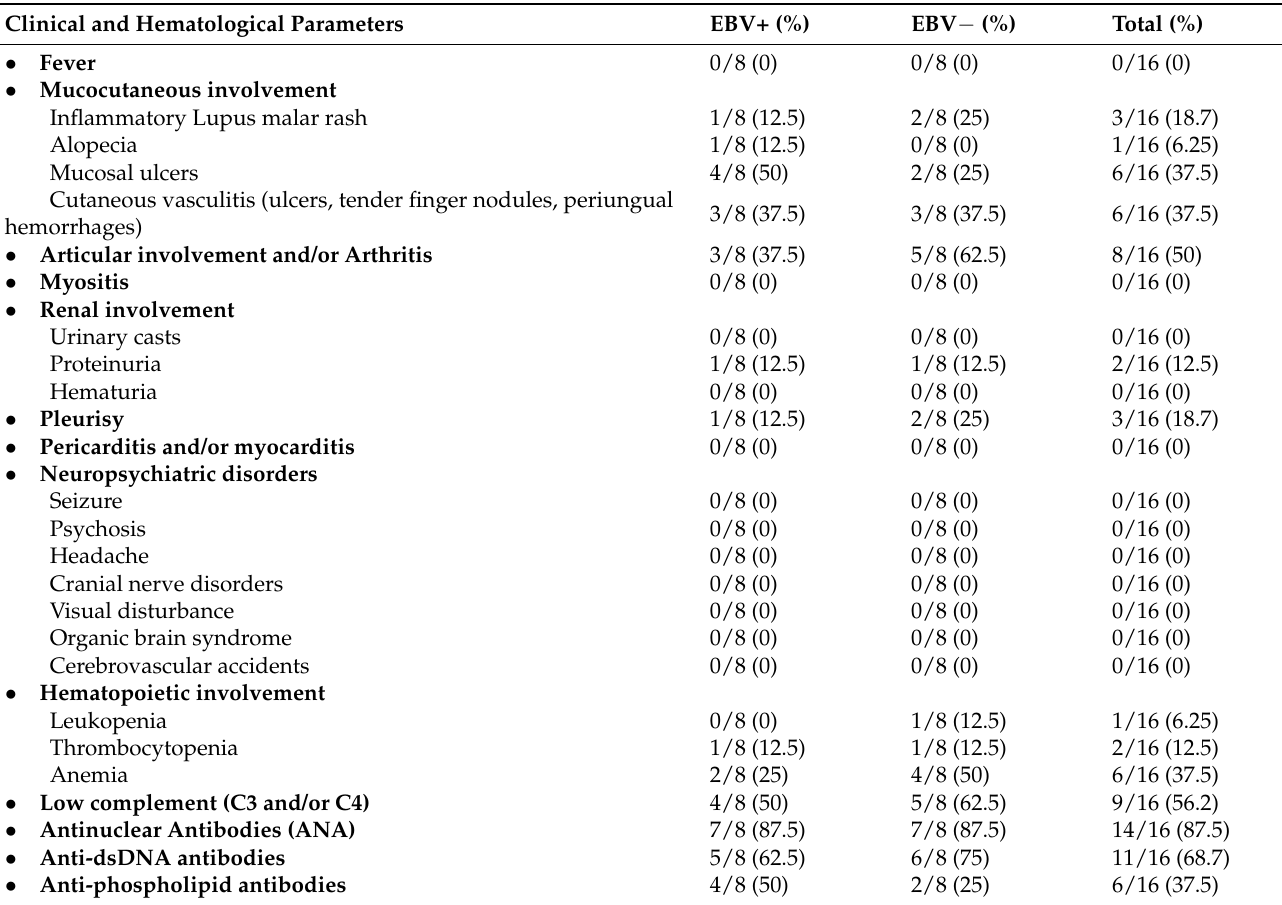
+: positive; − : negative; OR: odds ratio; CI 95% confidence interval 95%; * significant.